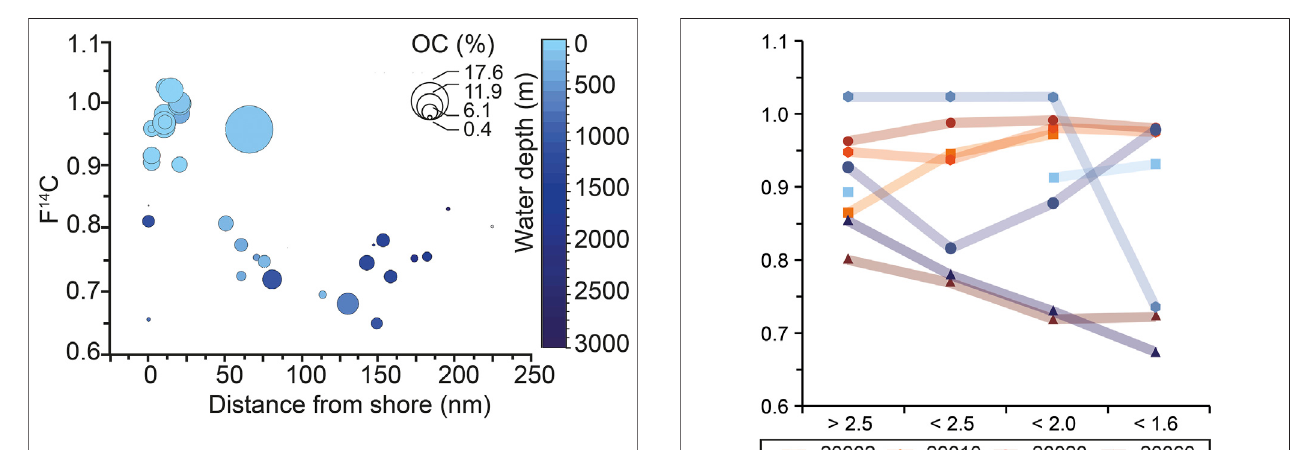
FIGURE 2 | OC age (expressed as F 14 C) illustrates the trend of increasing organic carbon age and decreasing organic carbon content with increasing distance to shore and water depth across the shelf. The interval between 100 and 200 nm contains mostly stations from the depocenter at Lüderitz and down-slope stations (data mostly from Mollenhauer et al., 2003), while stations at the shelf depocenter (60 – 90 nm) report young OC ages. A clustering effect caused by sampling choice and lab procedure may not be excluded.